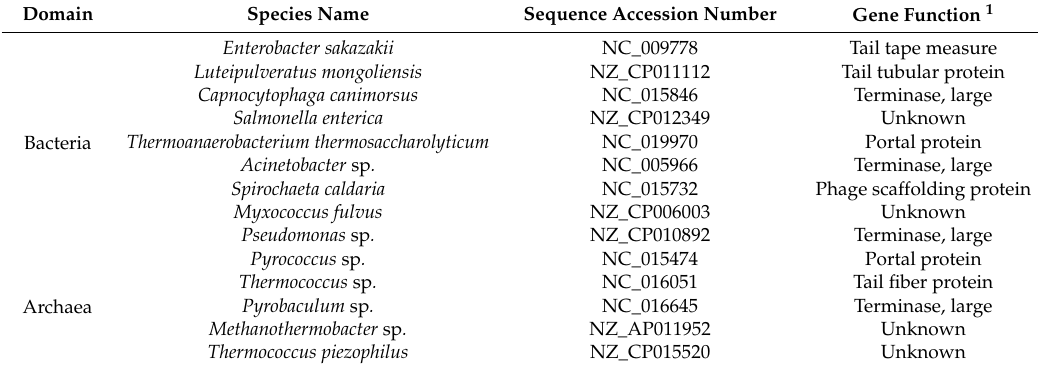
Table 3. Identification of putative virus hosts through interspaced short palindromic repeats (CRISPR) sequence